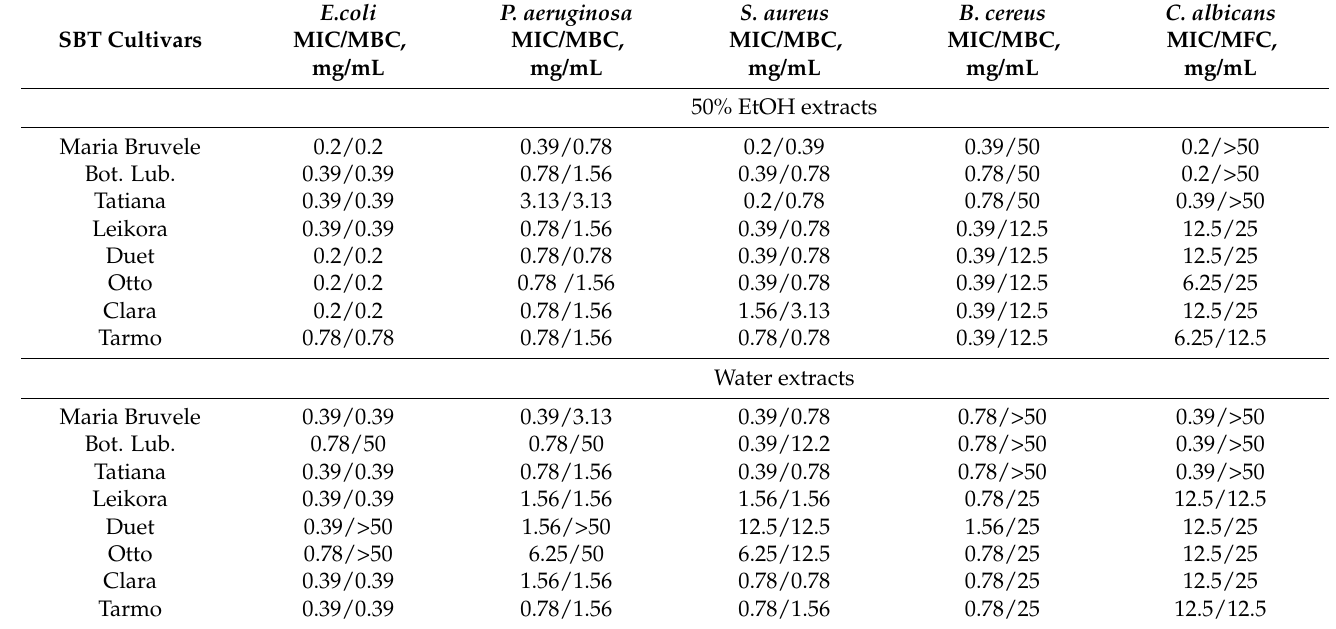
EtOH from eight SBT cultivars’ twigs is shown in Table 2. Table 2. Anti-bacterial and ant—fungal activity of the extracts from SBT samples.